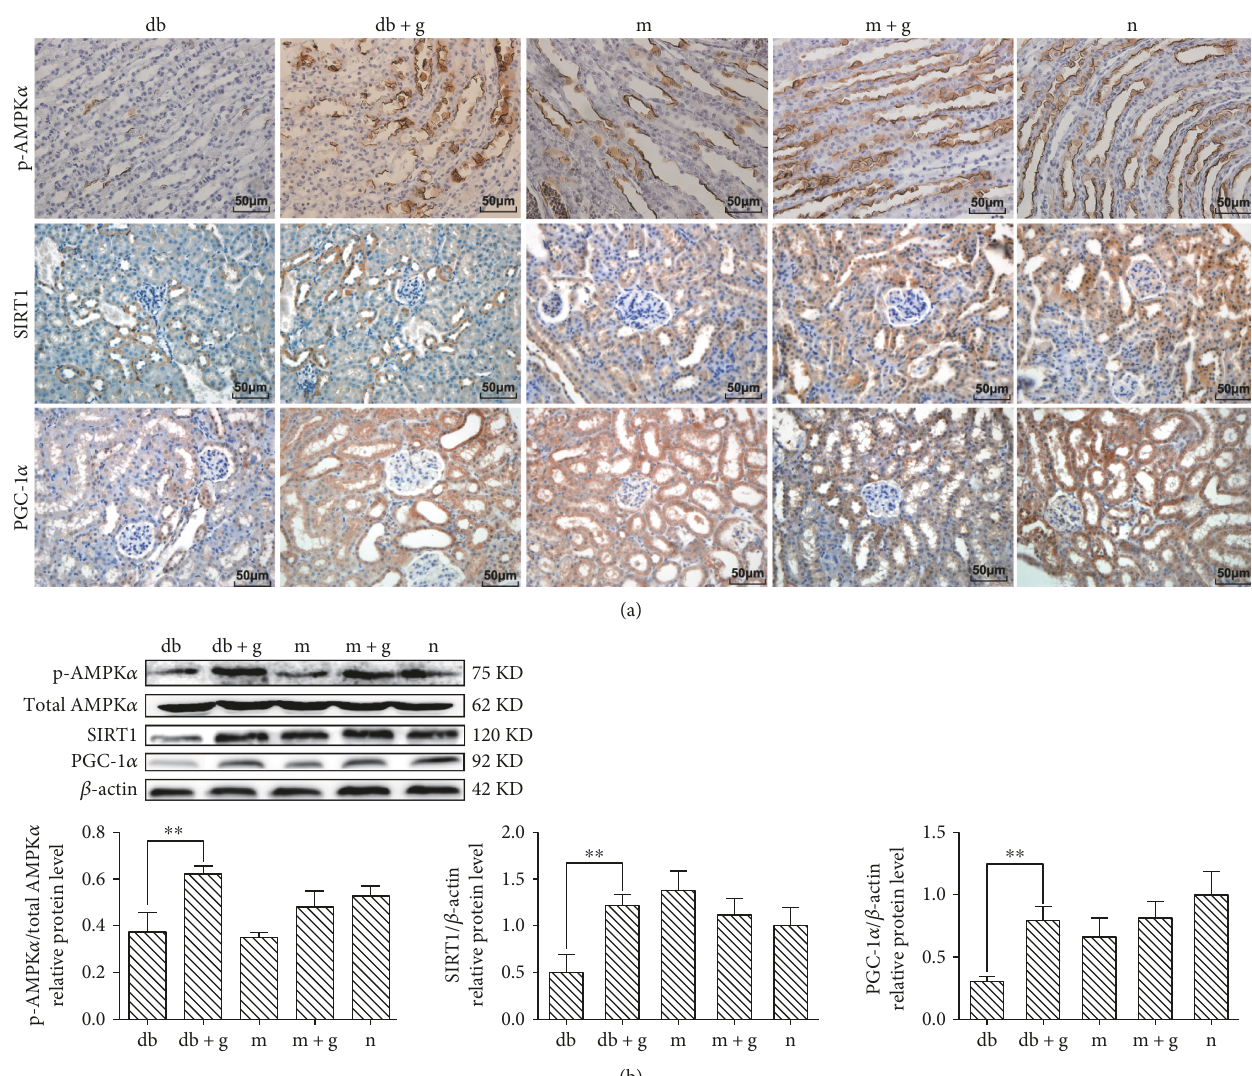
Figure 6: E ff ect of GA on p-AMPK α , SIRT1, and PGC-1 α expression in the kidneys of db/db mice. (a) Immunohistochemistry was used to detect p-AMPK α , SIRT1, and PGC-1 α in mice treated with GA. Original magni fi cation: × 400. (b) Western blot analysis was used to detect speci fi c proteins, and the proportion of cells with positive protein expression was determined. Histogram values represent the mean ± SD ( ∗∗ p < 0 05 ). β -actin was detected to con fi rm equal loading. The gray graphs show the relative protein levels in each